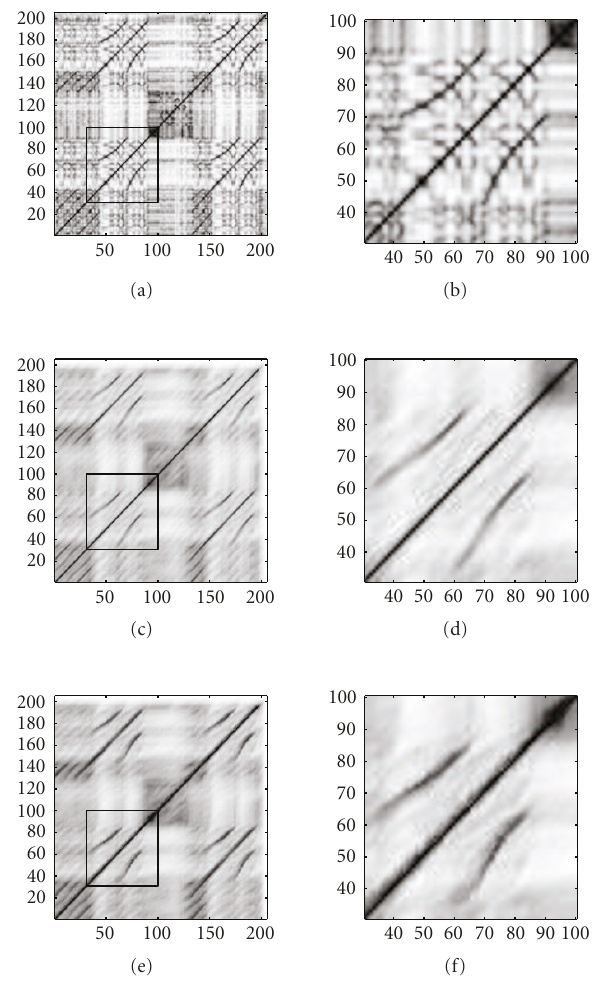
Figure 7: Enhancement of the similarity matrix of the Brahms ex- ample; see Figure 1. (a) and (b): S [41,10] and enlargement. (c) and (d): S 10 [41,10] and enlargement. (e) and (f): S min 10 [41,10] and en-